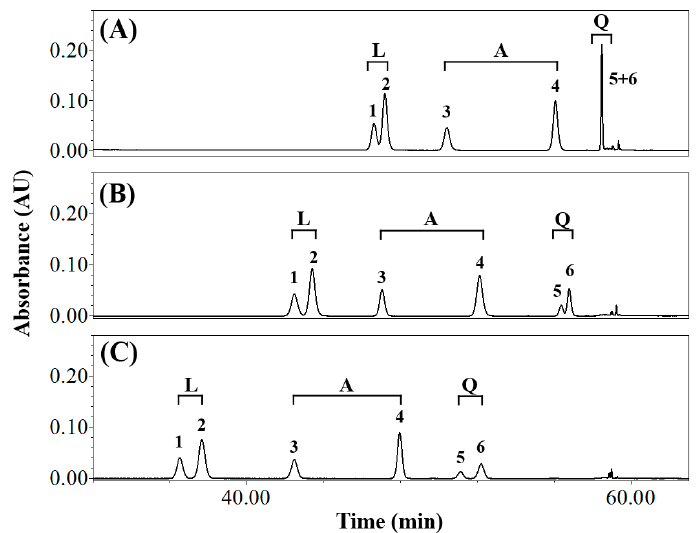
Figure 1. Reversed-phase high-performance liquid chromatography (HPLC) traces of common buckwheat sprout extract acquired at: ( A ) 20 ◦ C, ( B ) 30 ◦ C, and ( C ) 40 ◦ C detected at 360 nm.